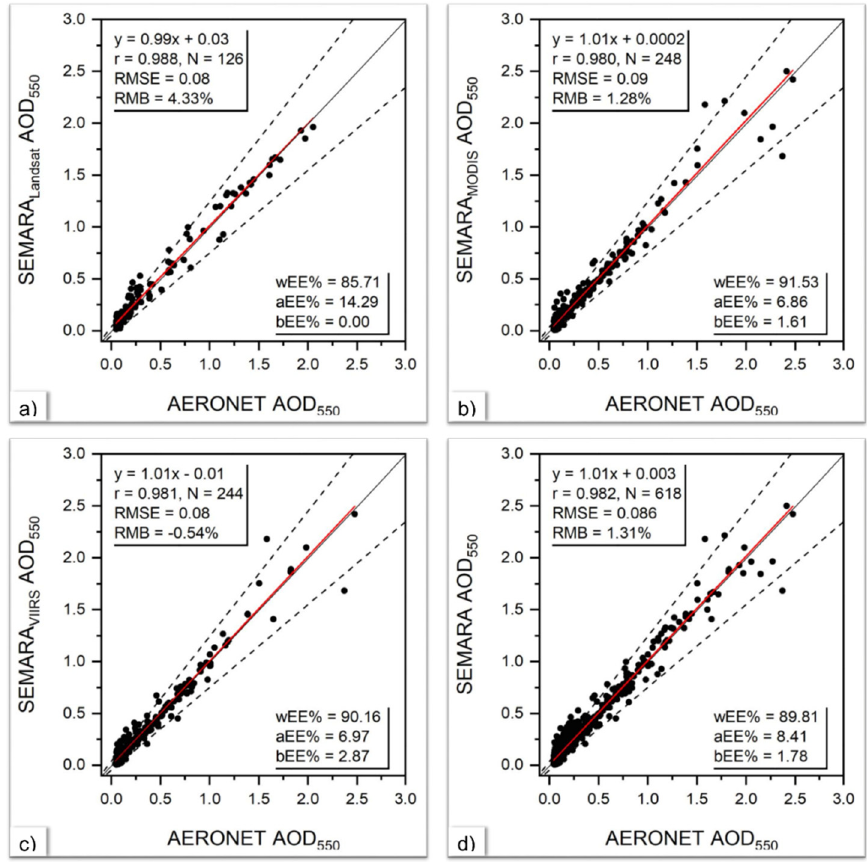
Figure 1. Validation of the SEMARA-retrieved AOD at ( a ) 30 m resolution from Landsat 8 OLI, ( b ) 500 m resolution from Terra-MODIS, ( c ) 750 m resolution from VIIRS, and ( d ) combined AOD retrievals from all three sensors, using AOD measured at two AERONET sites (Beijing_CAMS and Beijing_RADI) located in Beijing as independent references. The solid and dotted black lines represent the 1:1 (y = x) and EE lines, respectively, and the solid red line represents the regression line calculated using the RMA regression. Statistics metrics are provided in the legend in the top left corner of each figure.